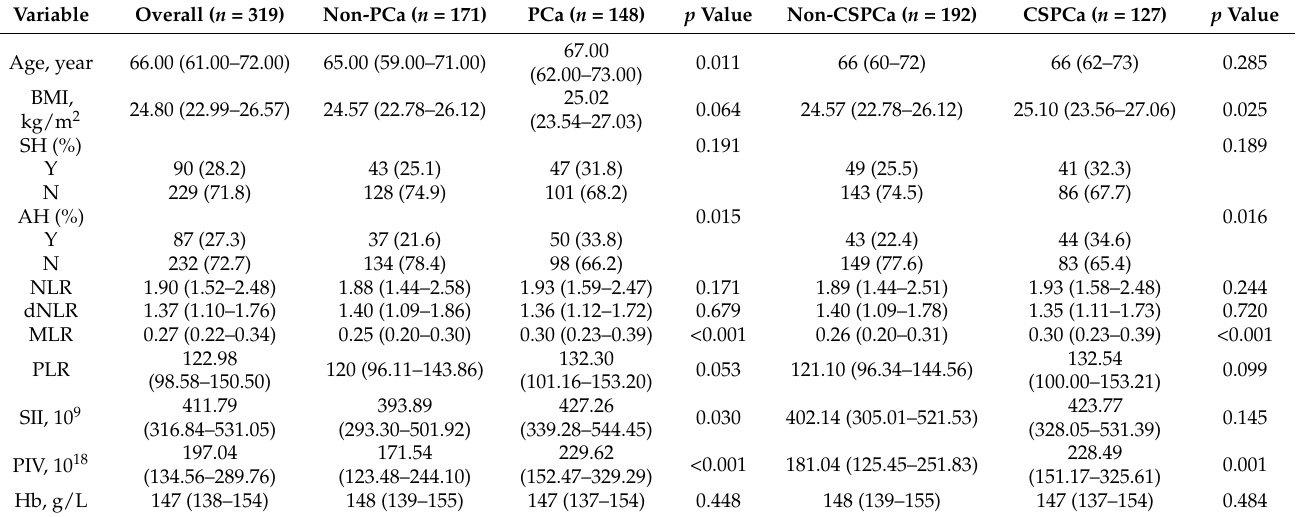
Table 1. Characteristic